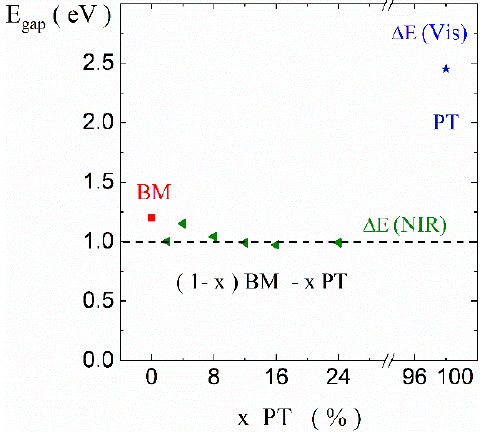
Figure 12. Optical energy gaps estimated for BM, PT, and (1 − x ) BM– x PT ceramic composites ( x = 0.02, 0.04, 0.08, 0.12, 0.16, and 0.24).